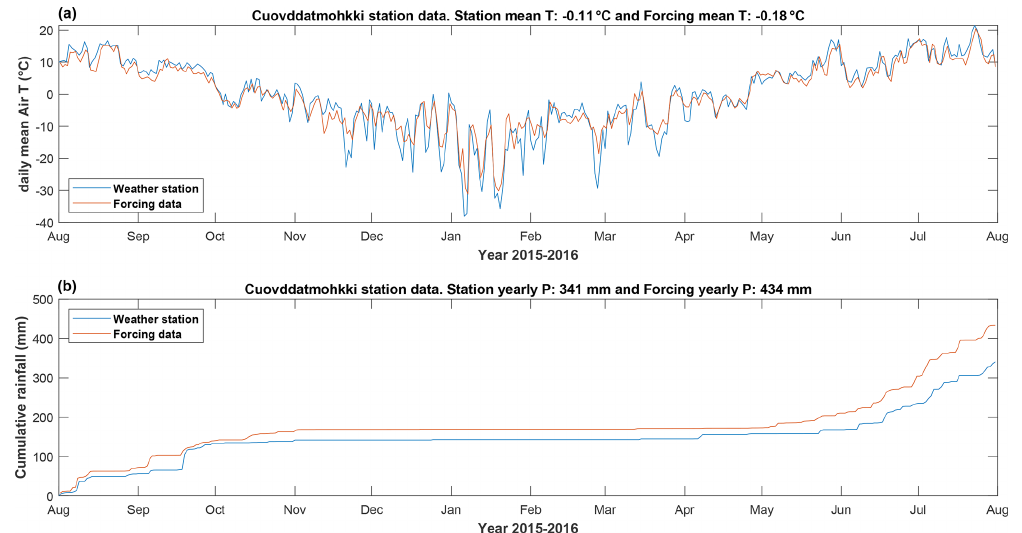
Figure A3. Comparison between the weather station and forcing data. (a) Daily mean temperature of the air 2m above the surface. (b) Cu- mulative rainfall. The station is Cuovddatmohkki station located at 286ma.s.l., 7km east from Šuoššjávri (310ma.s.l.).